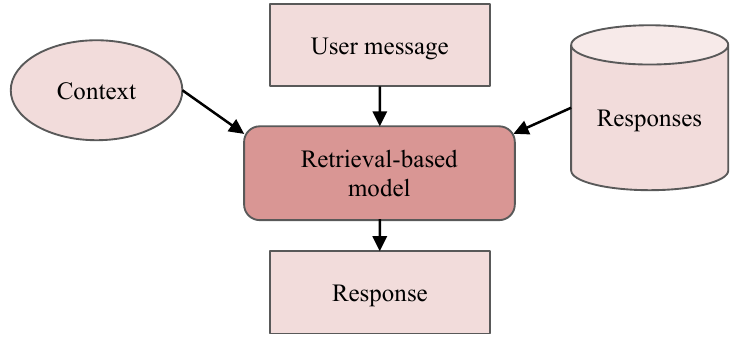
Fig. 2. Retrieval-based